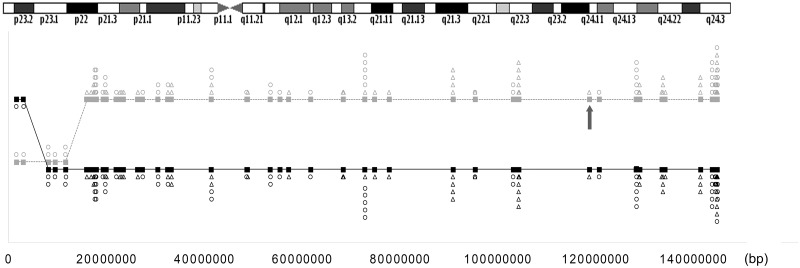
Representation of paternal heterozygous SNPs of chromosome 8 and its segregation in embryos F2E2-RG (healthy) (solid black line) and F2E1-GEH (affected by exostosis) (dashed gray line).Of the informative SNPs inherited from the father in each of the two embryos, the SNPs alternately inherited are represented with a triangle while the segregation of the 100% informative SNPs are represented with a circle. Mutation is represented with an arrow.